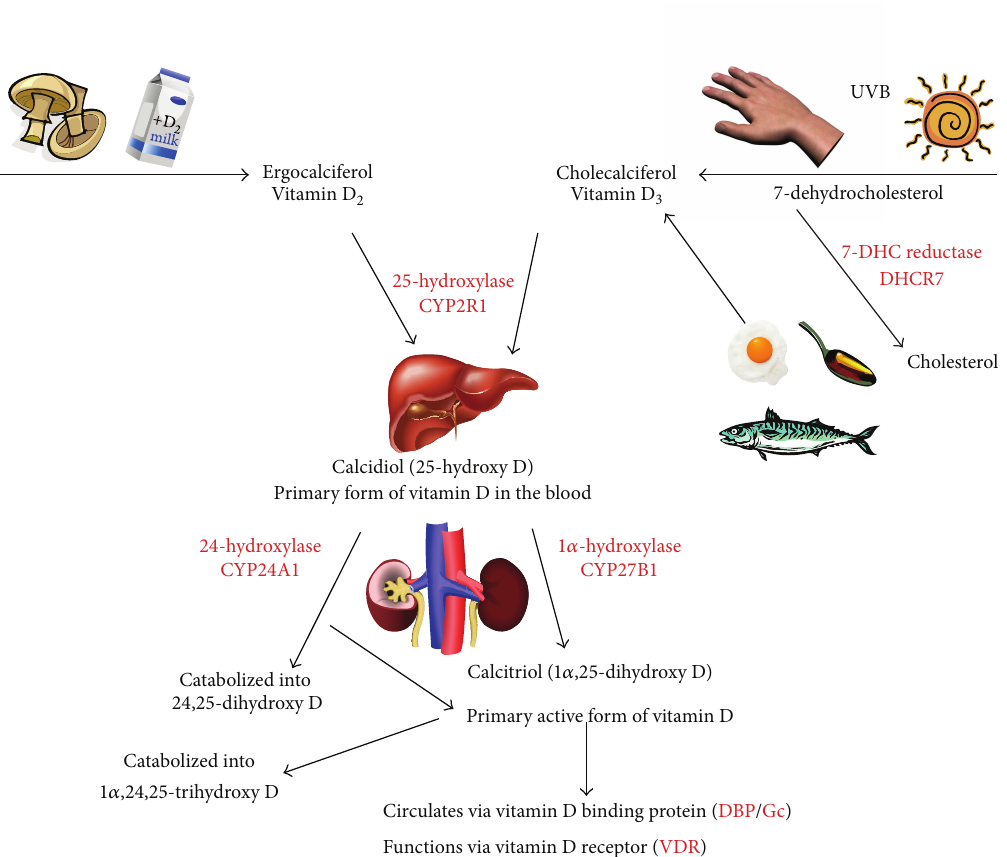
Figure 1: Vitamin D metabolism pathway. Proteins with genetic polymorphisms associated with vitamin D deficiency are highlighted (red).